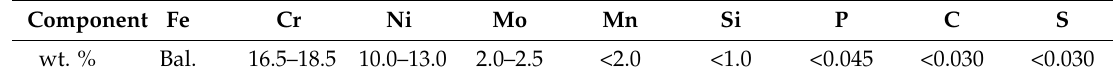
Table 1. Chemical composition (wt. %) of 316L SS powders used in this study. Component Fe Cr Ni Mo Mn Si P C S wt.